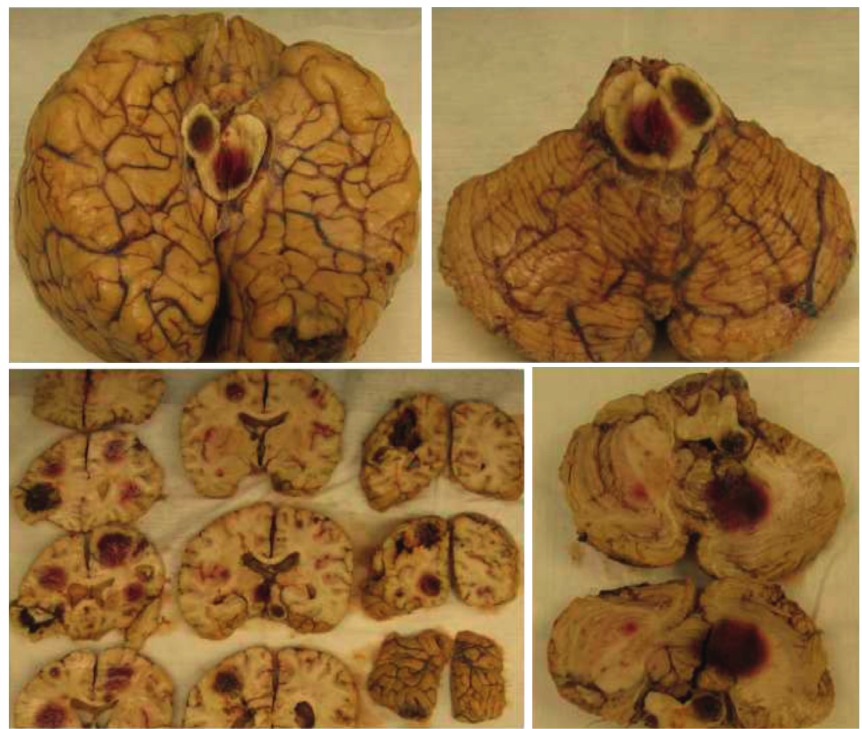
Figure 2: Autopsy brain. Multiple hemorrhagic necrotic lesions are present in the brain parenchyma including the cerebrum, cerebellum, and